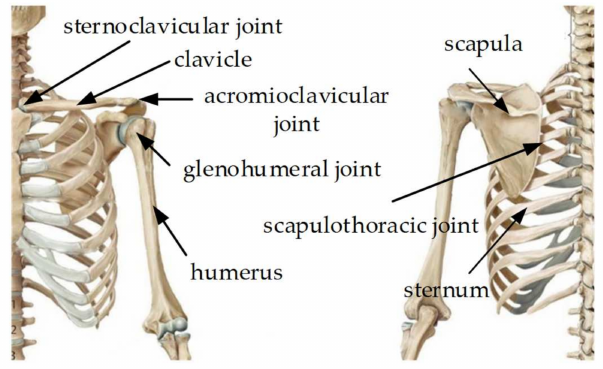
Figure 1. Physiological structure of the human shoulder joint complex.